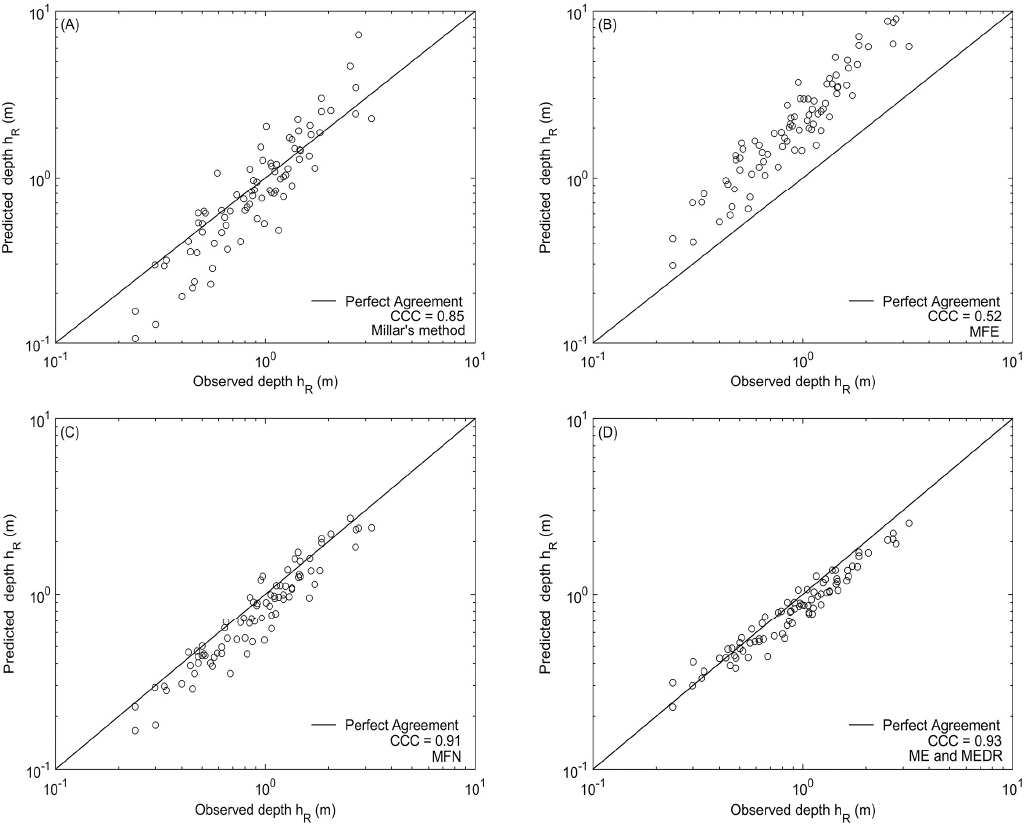
Figure 6. Comparison of predicted and observed depth h R for gravel bed channels [2,17,48,49]. ( A ) Millar’s Method; ( B ) MFE; ( C ) MFN; ( D ) ME and MEDR.